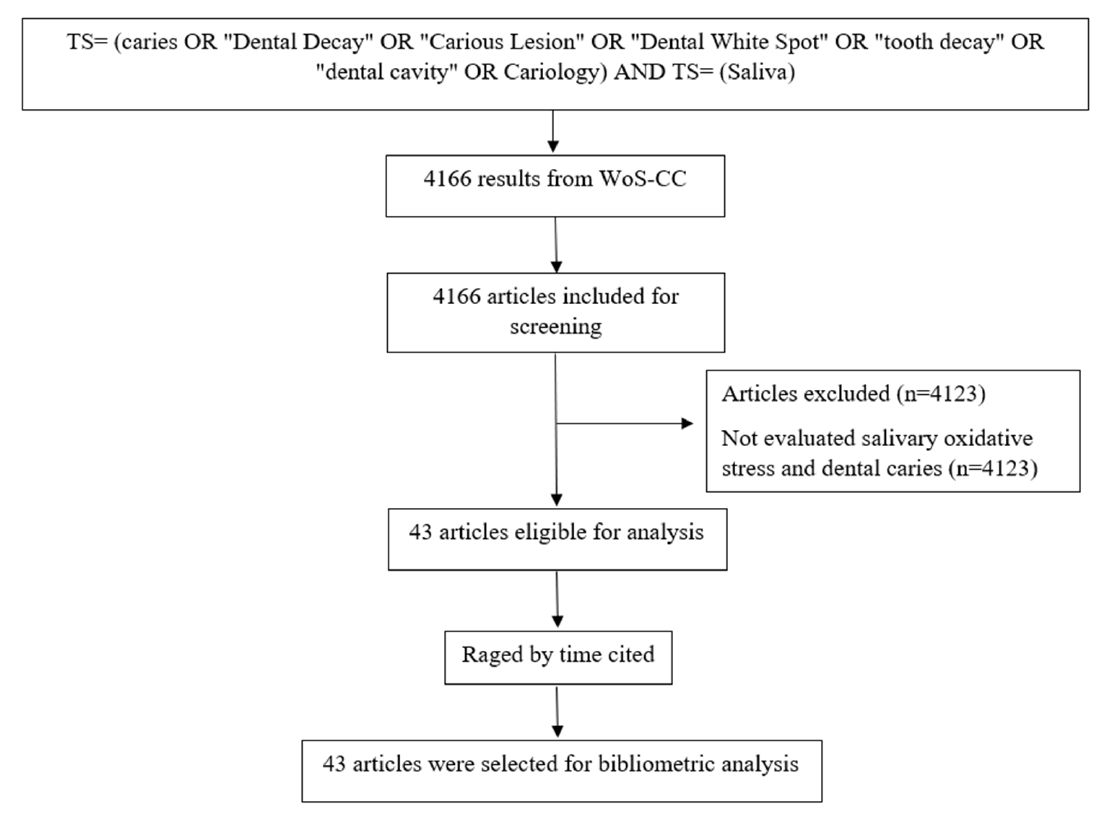
Table 2. Publication period of the selected articles.